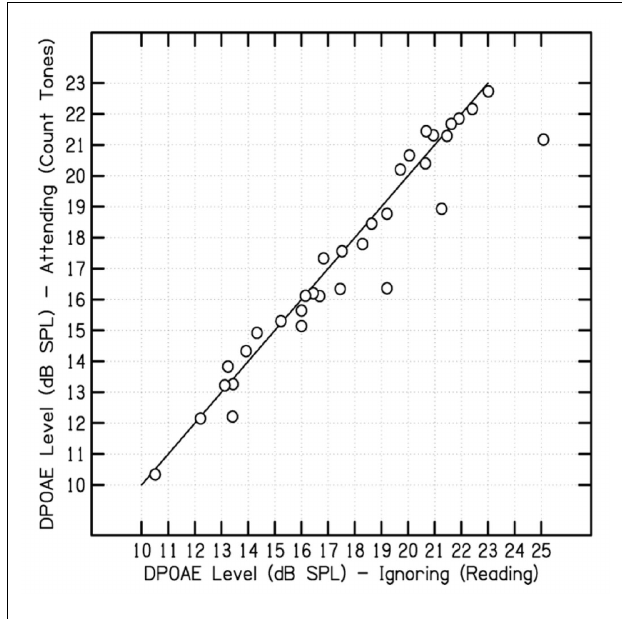
FIGURE 2 | Scatter plot comparison of the absolute DPOAE level measured for each subject during the auditory-attending condition (counting tones) and DPOAE levels obtained during the auditory-ignoring condition (reading text) in Experiment